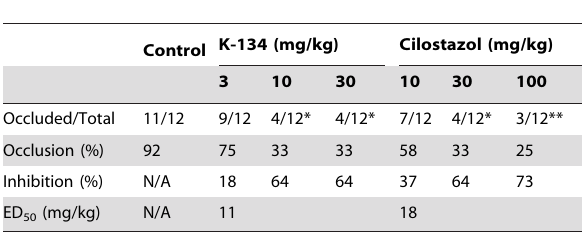
Table 1. Inhibitory effects of PDE3 inhibitors on arteriovenous shunt thrombus formation.